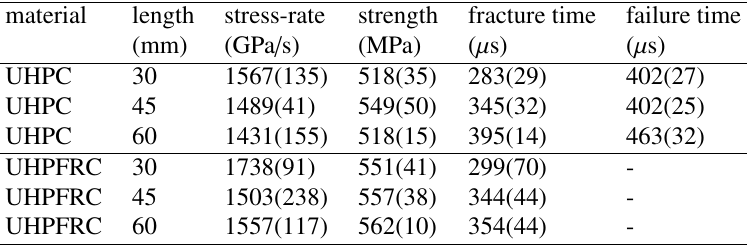
Table 2. Results obtained under the same pre-load and pre-strain.